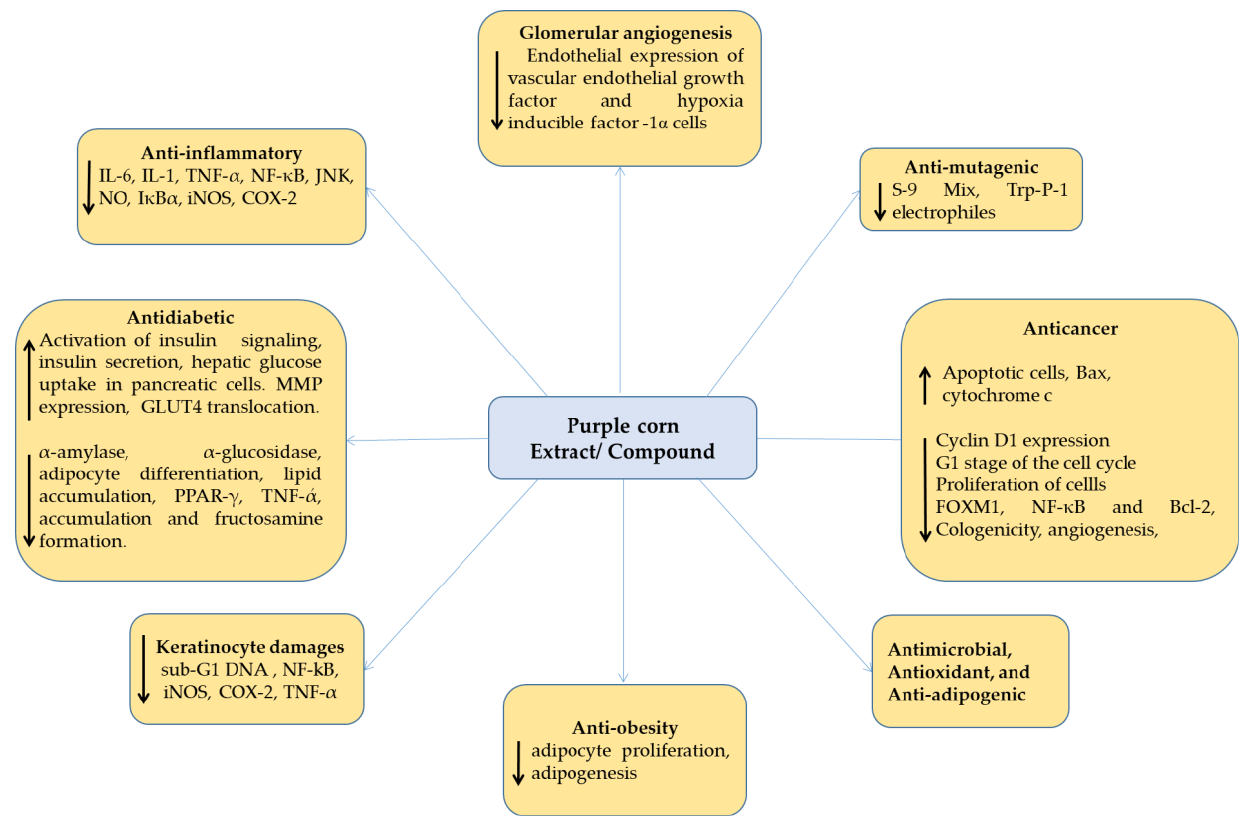
Figure 3. In vitro biological properties and mechanisms of purple corn. Table 1. In vitro biological properties of extracts and compounds from purple corn.